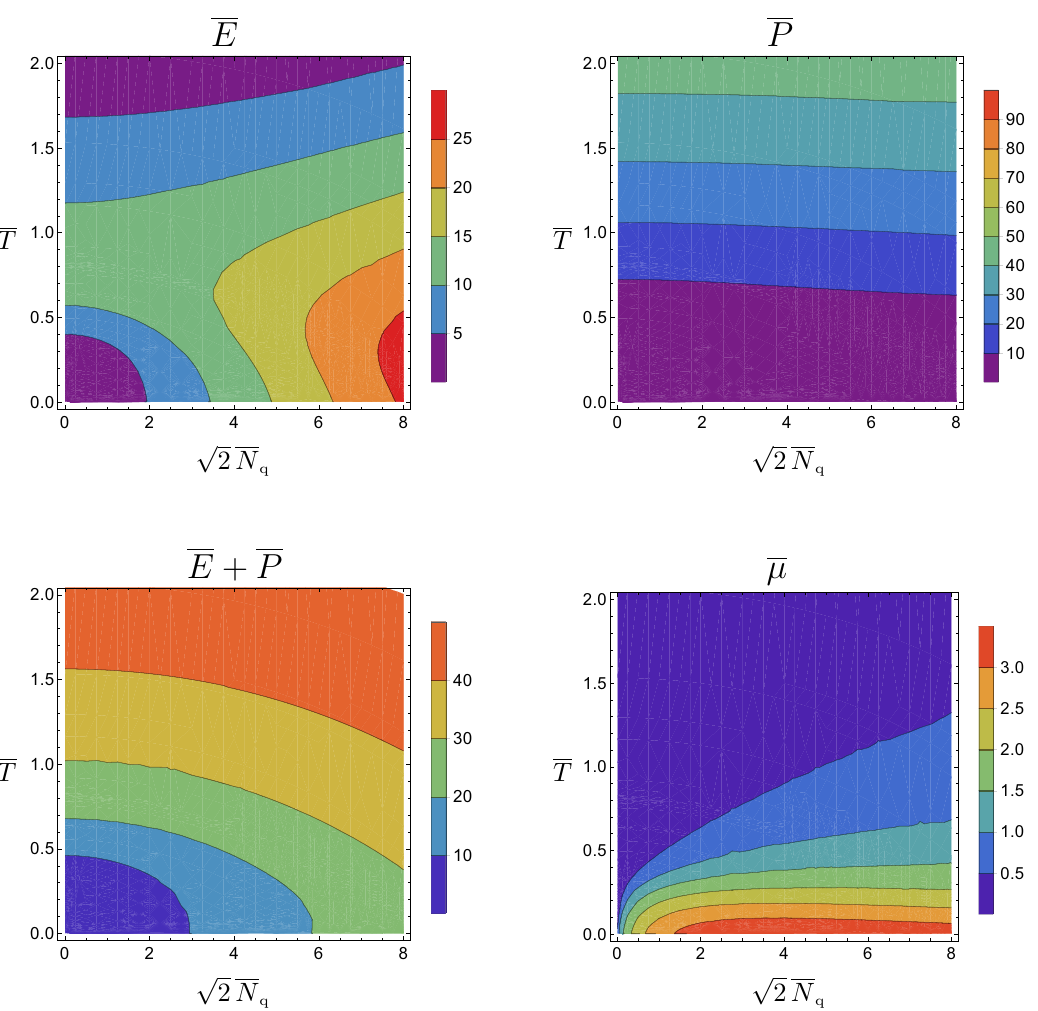
Figure 13 . Dimensionless energy density, pressure, enthalpy and chemical potential, as defined in (4.26) and